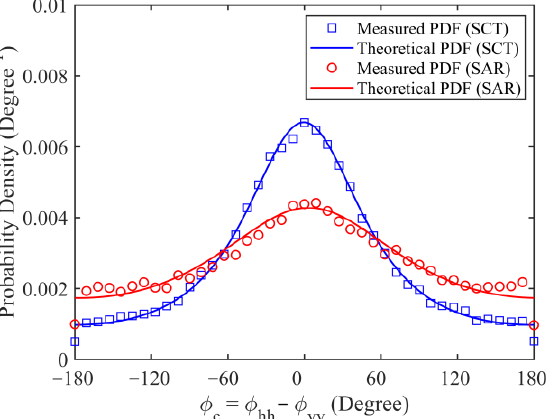
Figure 21. Comparison of co-pol phase difference statistics between scatterometric and SAR data.